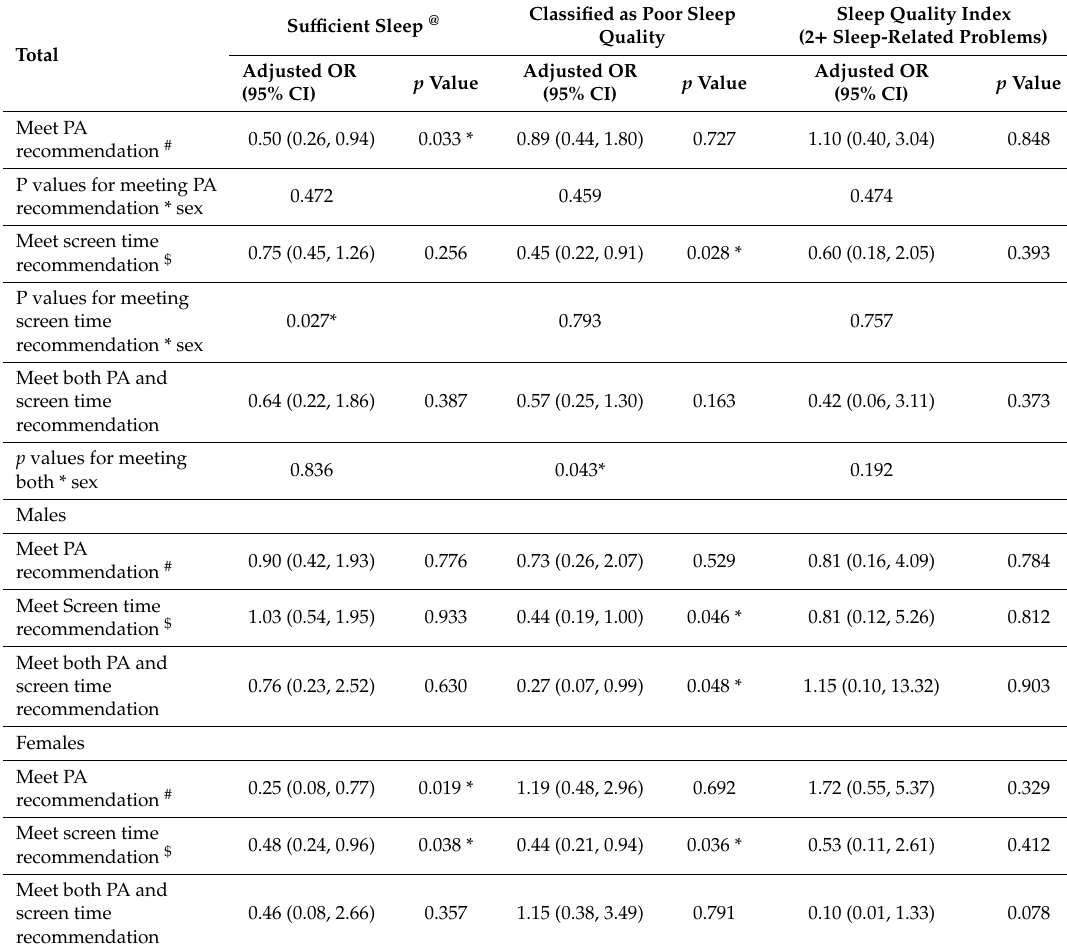
Table 2. The association between physical activity, screen time, and sleep quantity and sleep quality, 2005–2006 NHANES ( N =